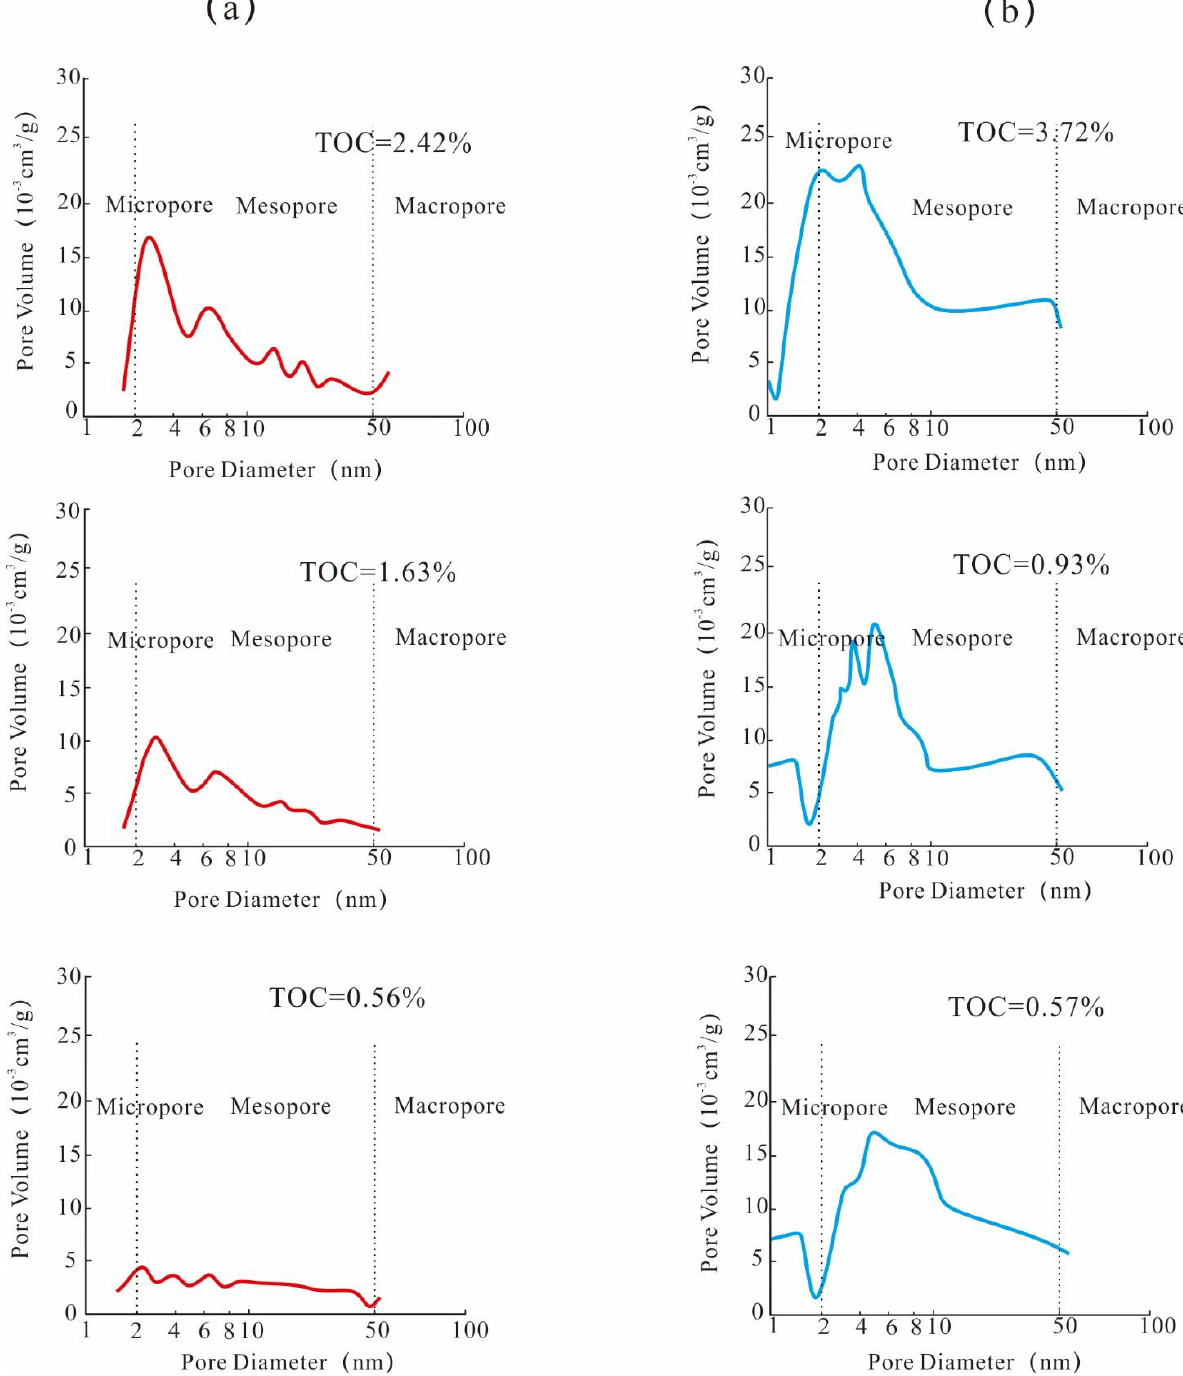
Figure 6. Total pore size distribution of typical marine shale samples and lacustrine shale samples ( a ) Pore diameter distribution of typical lacustrine shale samples from K 2 qn 1 Member, Da’an area, Songliao Basin; ( b ) Pore diameter distribution of typical marine shale samples from Longmaxi Formation, Changning area, Sichuan Basin [14].